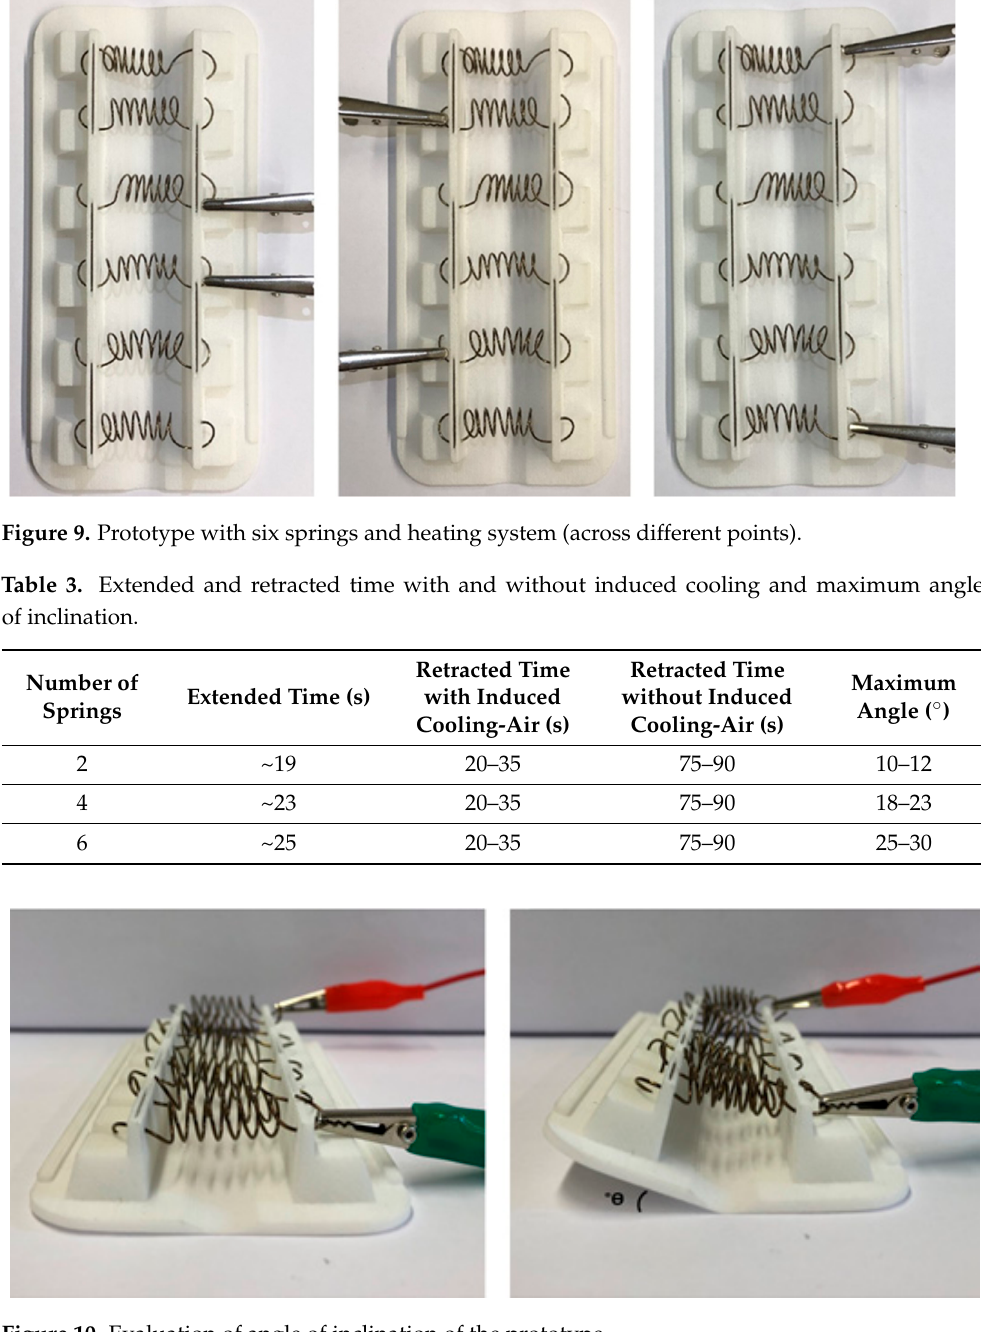
Figure 10. Evaluation of angle of inclination of the prototype. Table 3. Extended and retracted time with and without induced cooling and maximum angle of inclination.